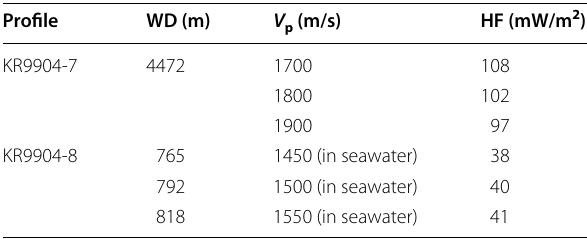
Table 1 Results of error evaluation